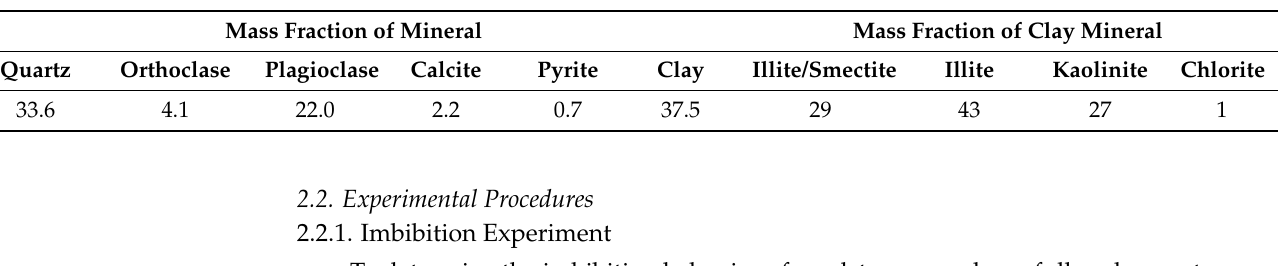
Table 1. Mineral content ( w t %) of the sandstone samples determined by